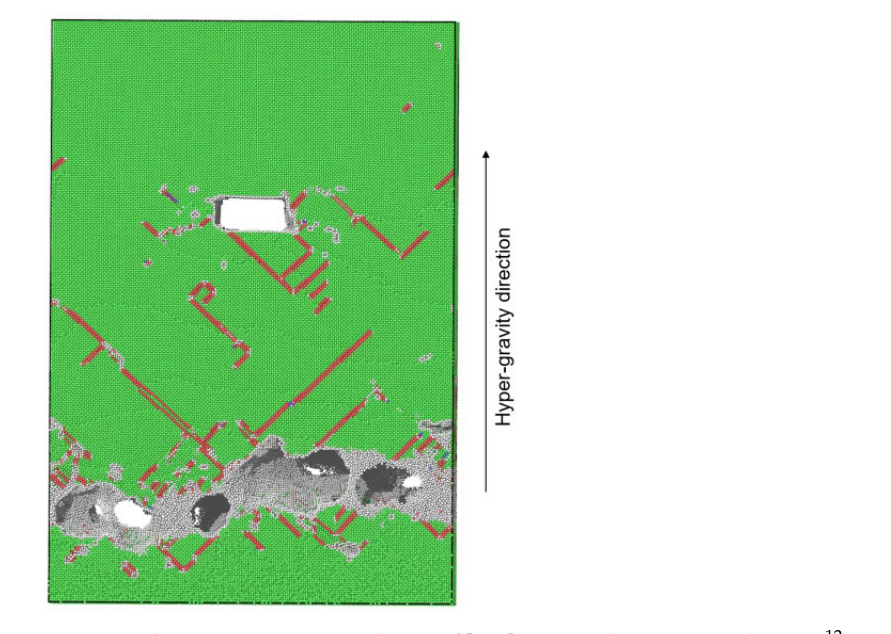
Figure 5. The microstructure evolution of [001](010) crack at 300 K and 8 × 10 12 g conditions. The green, red and grey color indicate FCC, HCP and unidentified structures, respectively.